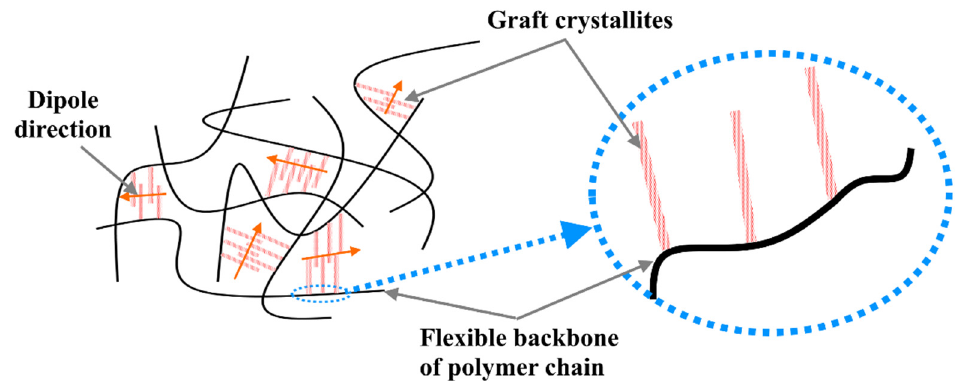
Figure 10. Schematic structure of electrostrictive graft elastomers.